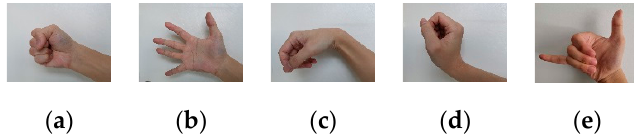
Figure 5. Five actions to be recognized. ( a ) Fist clenching. ( b ) Hand opening. ( c ) Wrist flexion. ( d ) Wrist extension. ( e ) Calling me. These actions are more common in daily lives and relatively easier to be recognized. Patients usually start with these basic movements in restoring hand function.